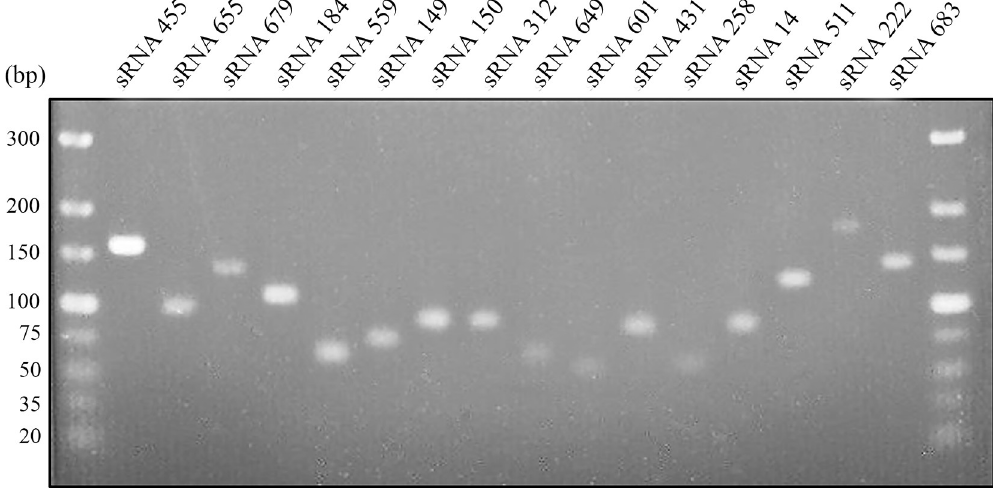
Fig 3. Detection by RT-PCR of the 20 sRNAs of P . pseudoalcaligenes CECT5344 with differential expression. Electrophoresis on 3% agarose gel of the PCR products corresponding to the 20 sRNAs induced or repressed in the jewelry wastewater. First and last lanes, TracKit Ultra Low Range DNA ladder